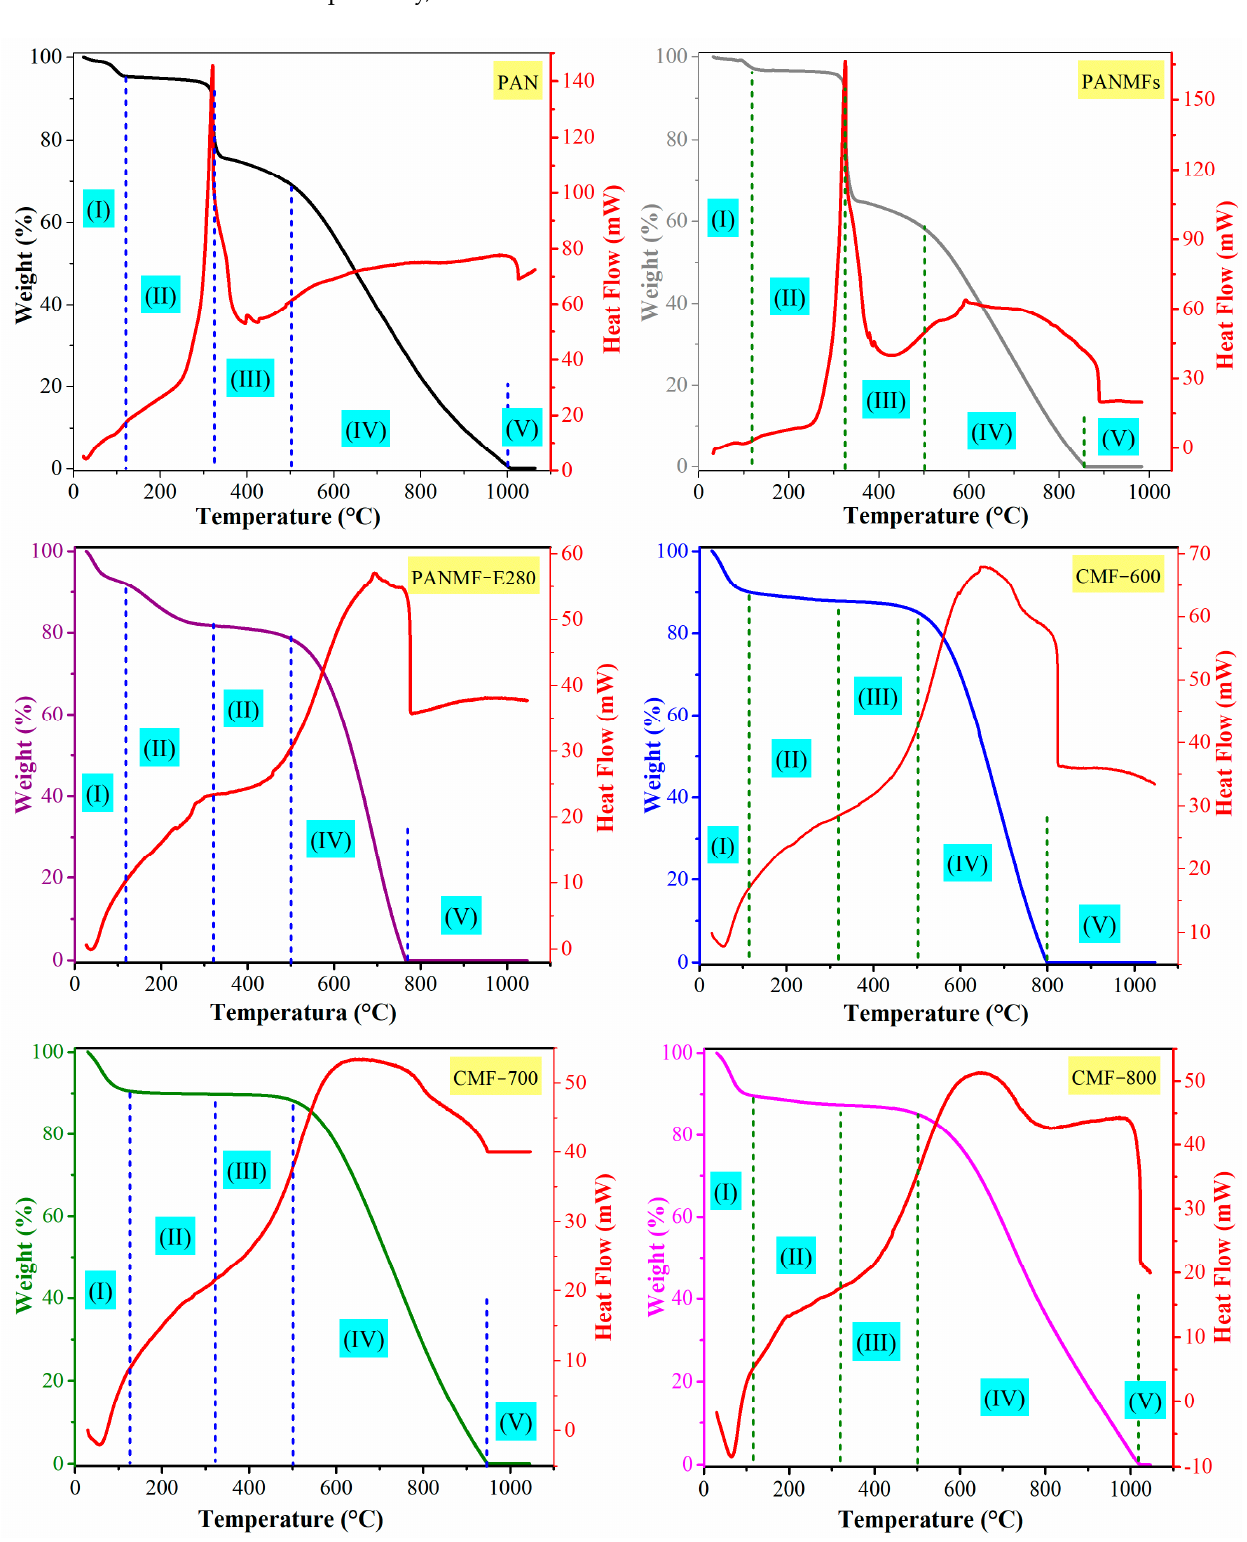
Figure 3. TG/DTA curves of PAN, PANMFs, and CMFs in nitrogen atmosphere: (I) desorption of physisorbed water, (II) cyclization and dehydrogenation, (III) dehydrogenation and denitrogenation, (IV) eliminating of some volatile components such as H 2 , CH 4 , CO, CO 2 , H 2 O, N 2 , NH 3 and HCN, and (V) complete thermal degradation of PAN.